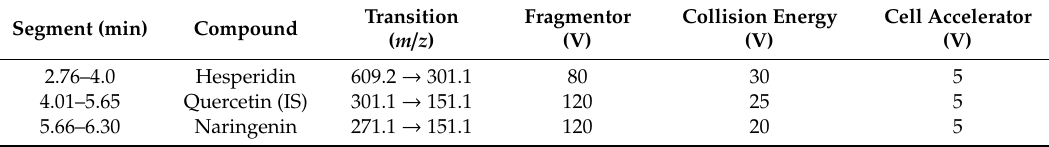
Table 7. MRM parameters for hesperidin, naringenin and internal